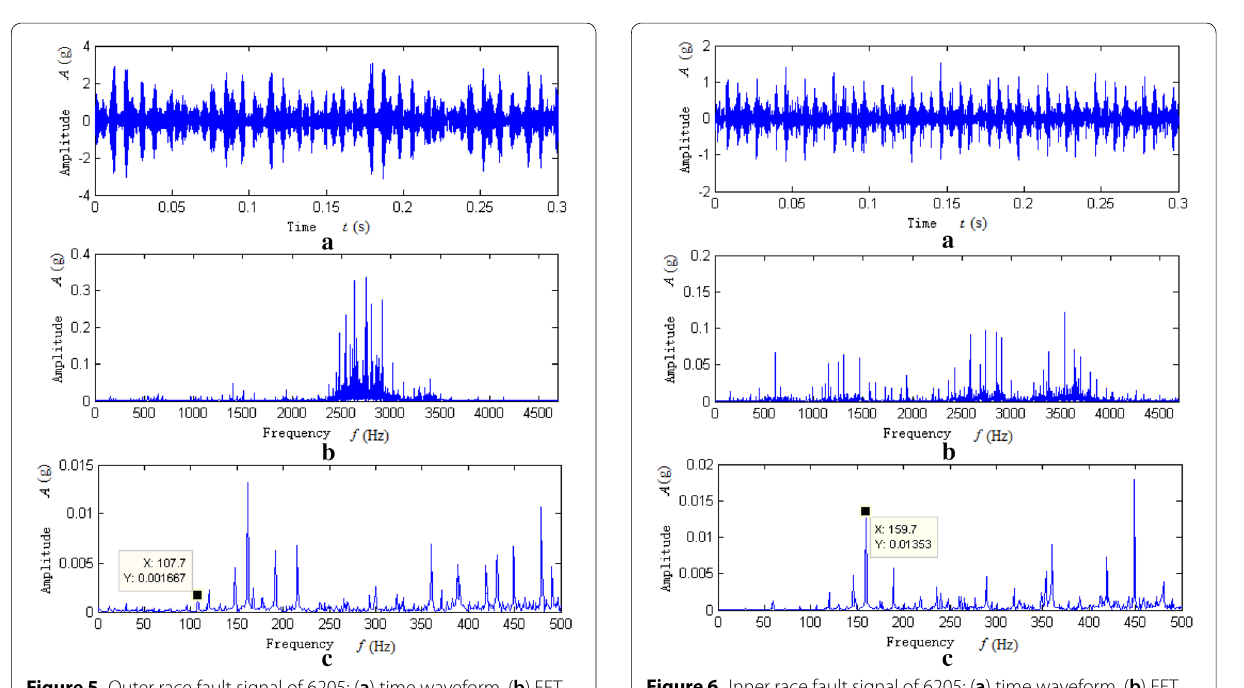
Figure 5 Outer race fault signal of 6205: ( a ) time waveform, ( b ) FFT spectrum, ( c ) local spectrum